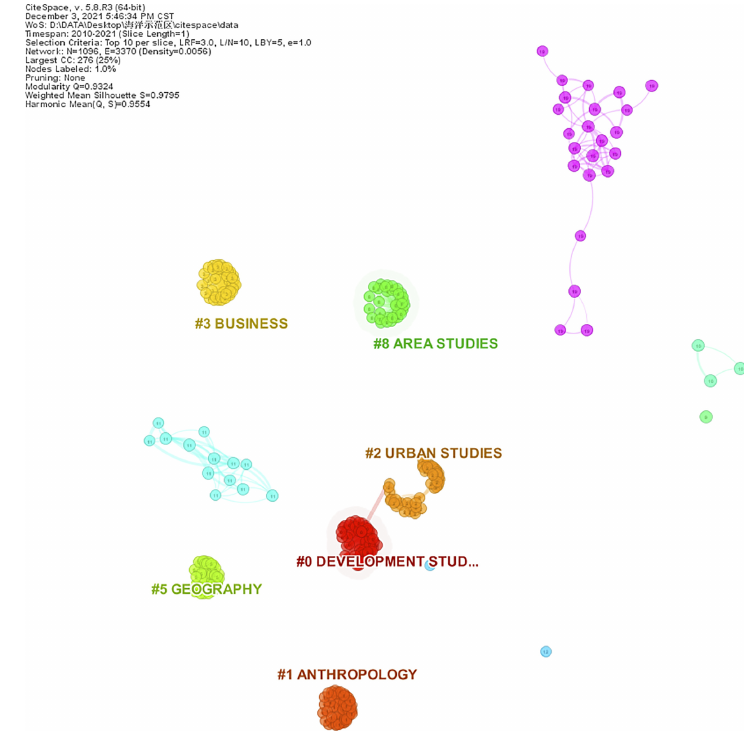
Figure 9. Literature co-citation